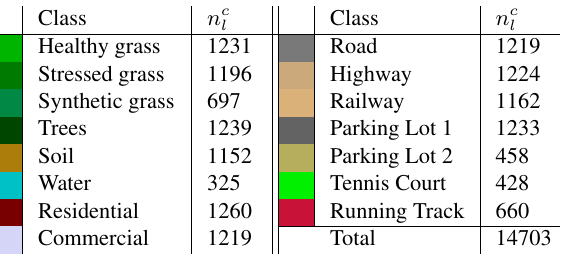
Table 3: Classes and Samples ( n c Houston 2013 dataset (cf. Fig.